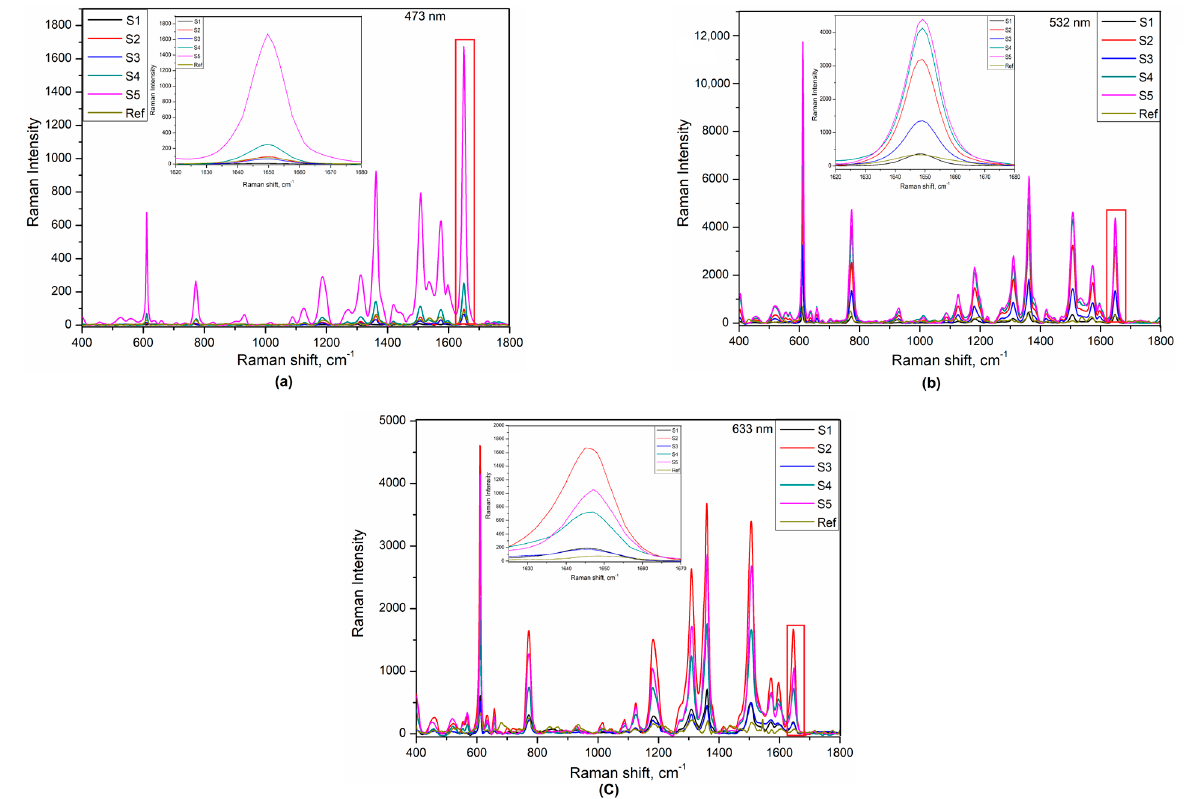
Figure 5. Raman spectrum of Rhodamine 6G measured on S1–S5 with three different excitation sources: 473 nm ( a ), 532 nm ( b ), and 633 nm ( c ). Please note the different vertical scales. The Raman spectrum of the analyte measured without nanostructure is included for reference.